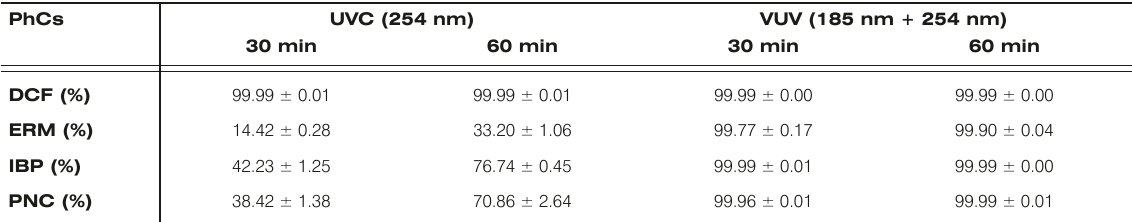
Table 4. Removal ration for selected PhCs due to UVC and VUV photolysis (n = 3) in mixed ultrapure water solutions.